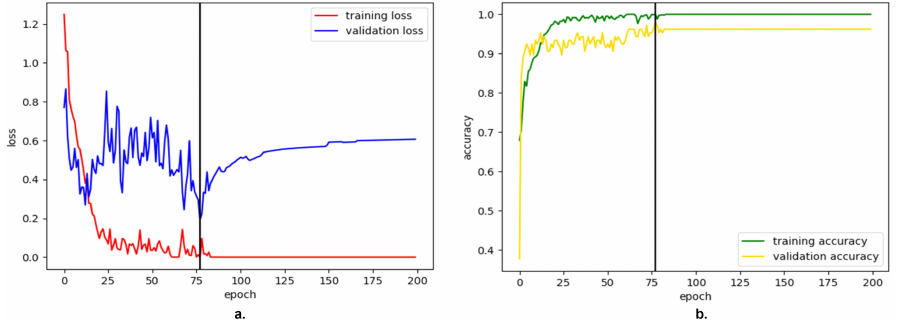
Figure 9. The results of using two hidden layers with a dropout probability of 0.5. ( a ) Training and validation for model training. ( b ) Training and validation for accuracy training.